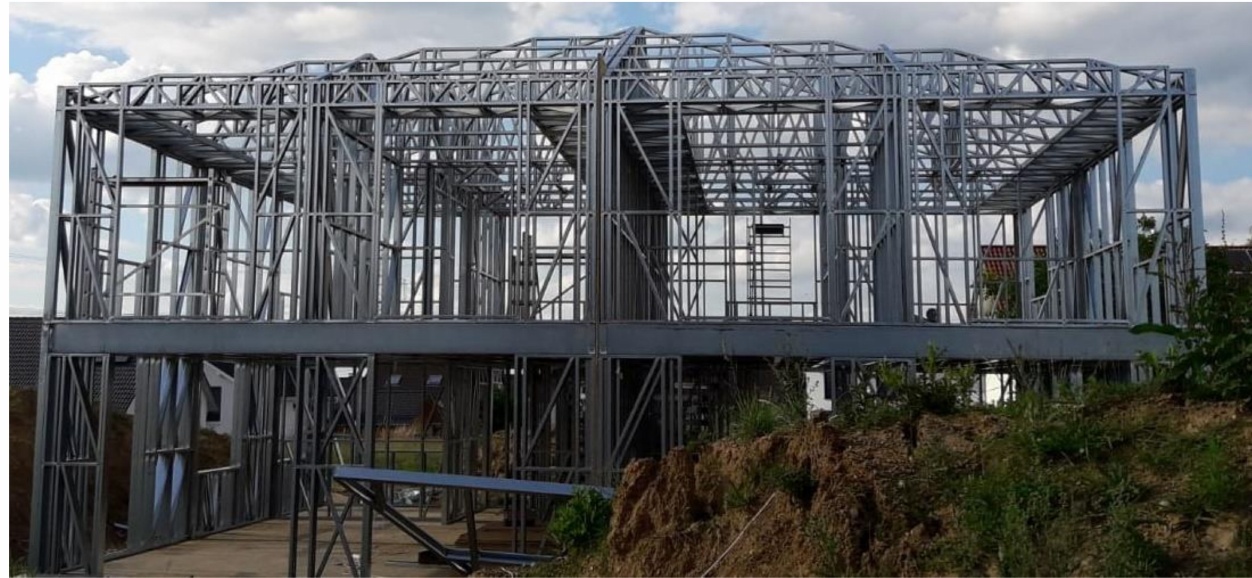
Figure 1. Example of structure for housing made of spatial frames and trusses from thin-walled C-shaped steel profiles, Germany 2018 (authors’ collection).